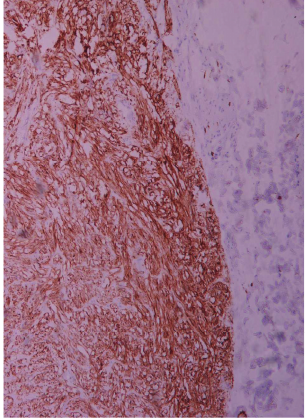
Figure 3: Gastric GIST, CD117 positive ( ×